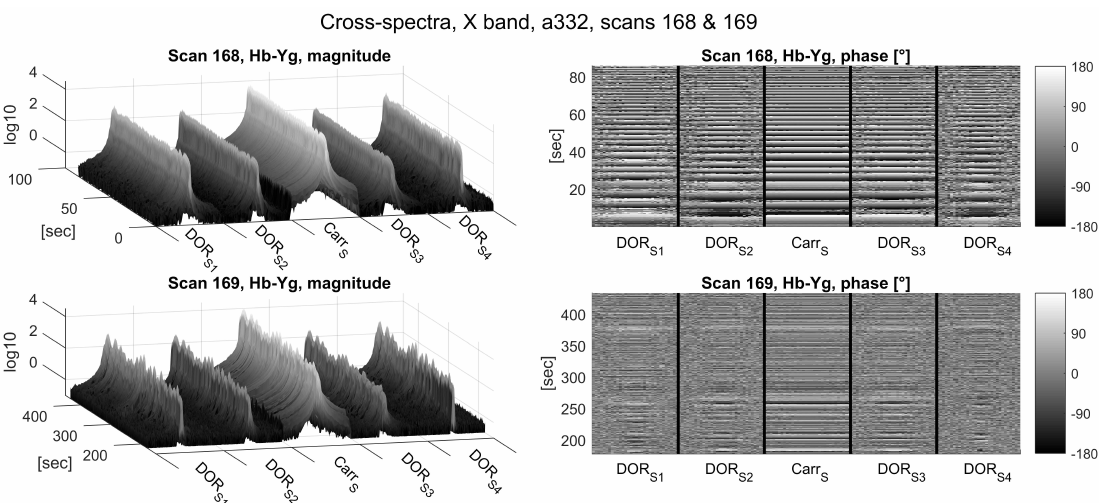
Figure 7. Cross-spectrum magnitudes (left column) and phases (right column) of the X-band zoom-bands of Scans 168 (upper panels) and 169 (lower panels) of Experiment a332. The frequency axes (horizontal axes) depict the five 32 kHz wide DiFX zoom-band described in Table 3 next to one another. The time axes indicate seconds since the start of Scan 168 (10:41:04 UTC).